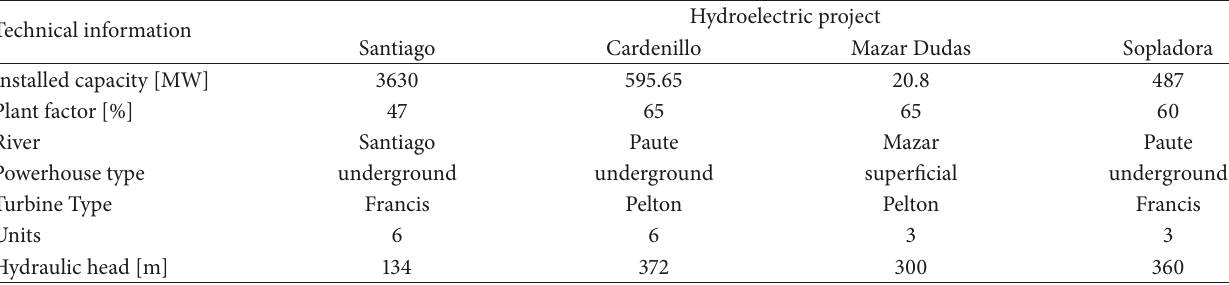
Table 1: Basic technical details of the hydroelectric power production projects